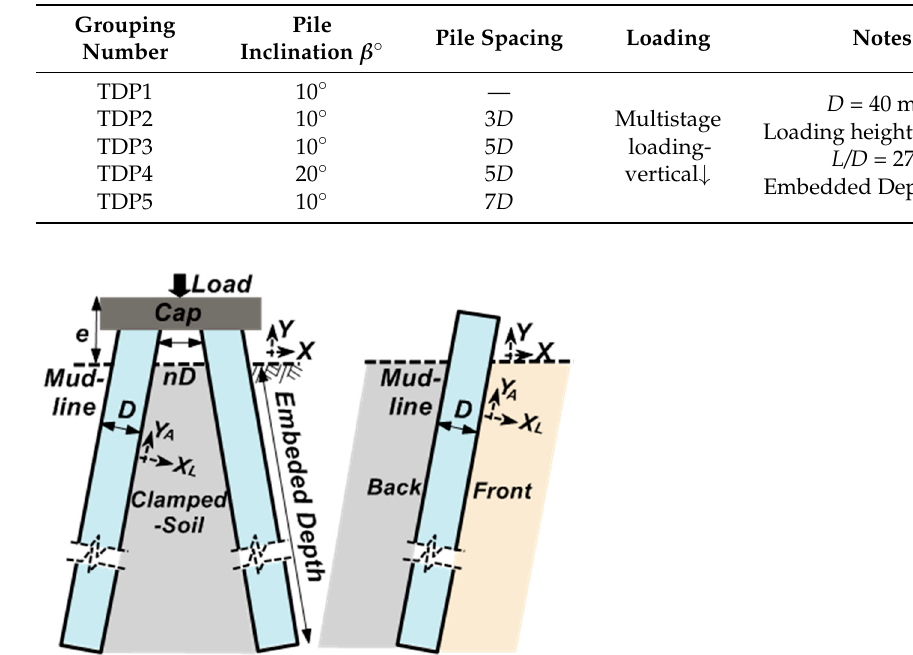
Table 1. Grouping of the tests.